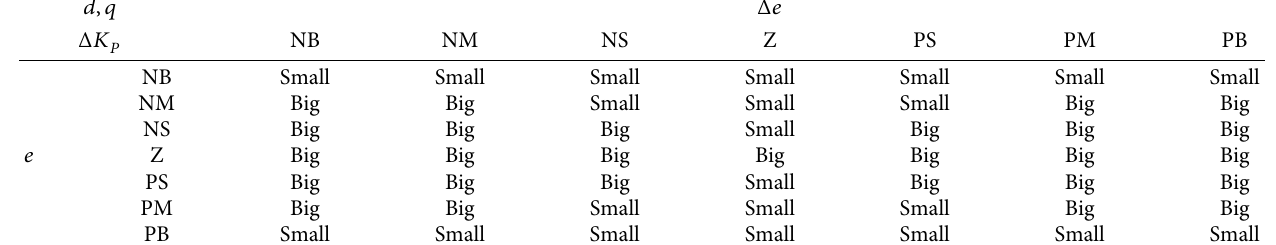
Table 9: Fuzzy linguistic rule and Δ K